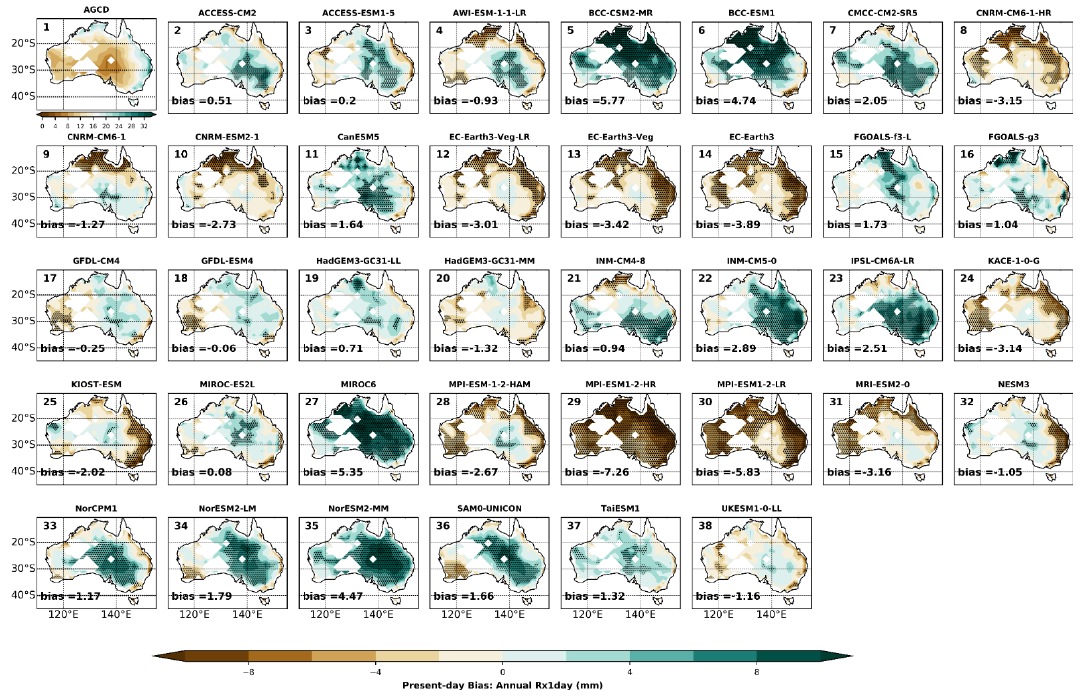
Figure 2. Climatological mean annual bias in maximum 1-day precipitation (Rx1Day: mm) relative to the Australian Gridded Climate Data dataset (AGCD; panel 1 ) for the individual CMIP6 GCMs (panels 2 – 38 ). Data spans 1951–2014. Stippling indicates statistically significant differences using a student’s t-test at the 95% confidence level. The white masks in part of the inland domain are the regions with no station data.